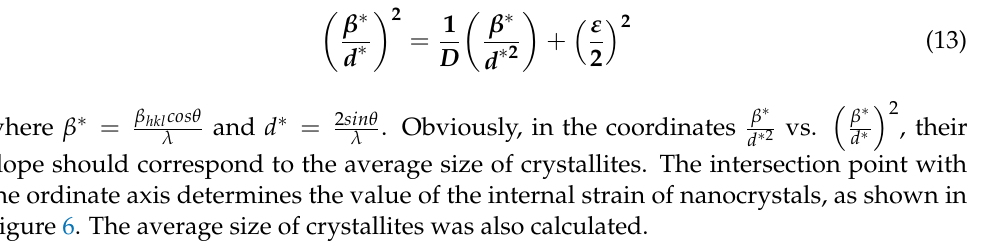
Figure 6. The average size of crystallites was also calculated.